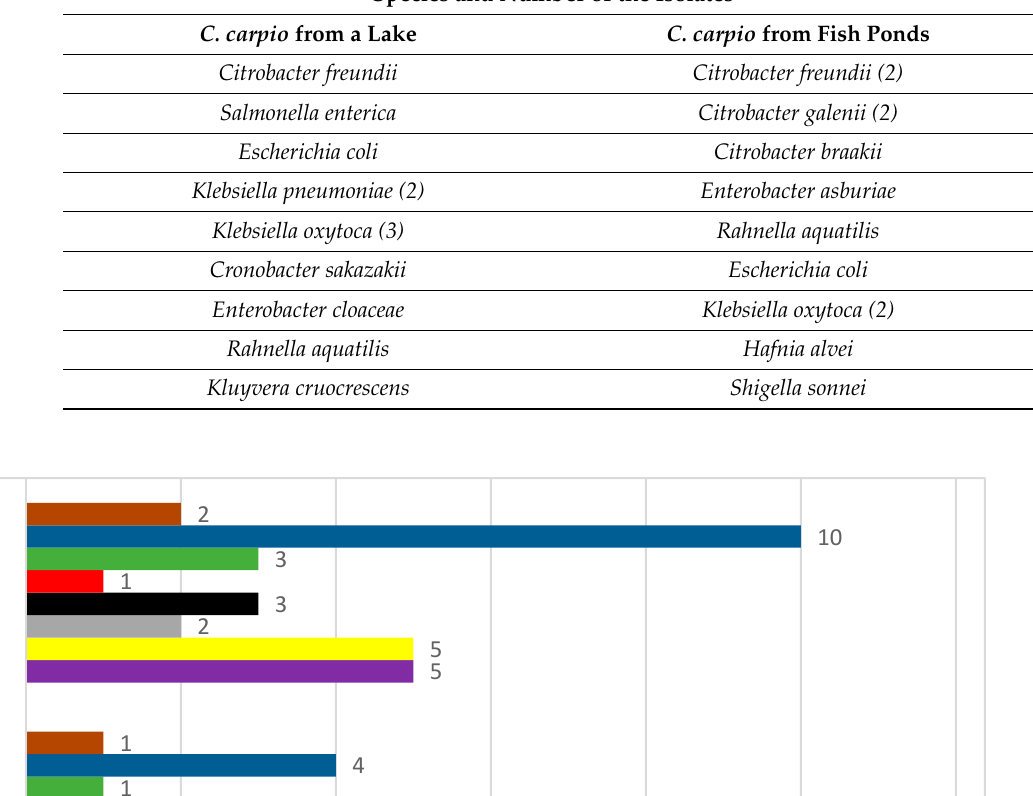
Species and Number of the Isolates